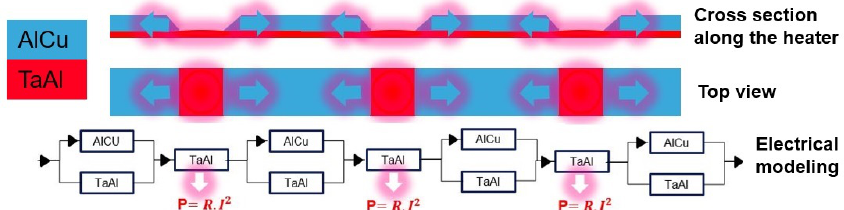
Figure 3. Cross-section view and top view of the composite heater along with its electrical modeling.